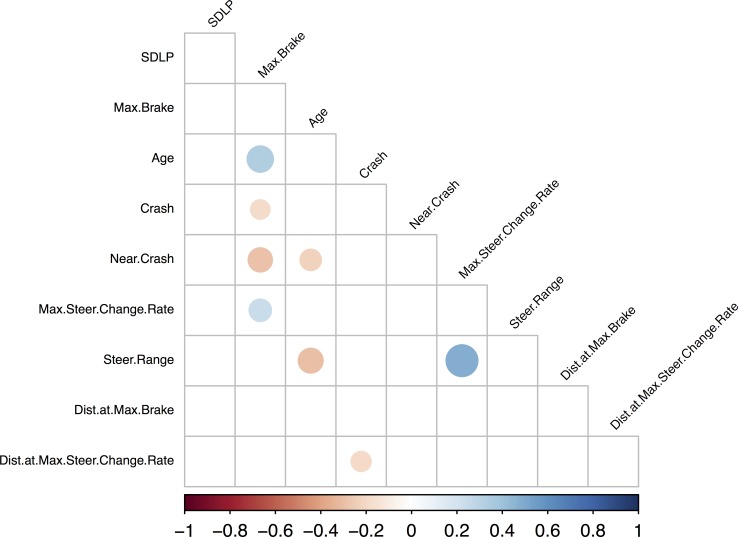
Graphical representation of the hcluster correlation analysis on the ‘Urban Scenario’ dataset controlling for mean speed.Only the significant correlations (p< .05) appear on this graphical representation.